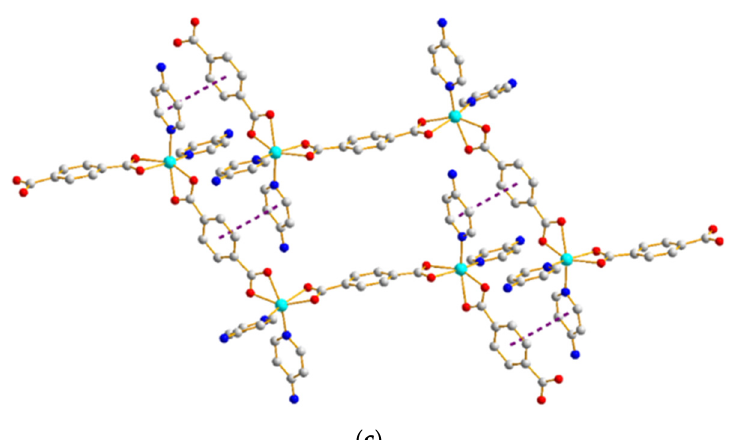
Figure 1. ( a ) A representative drawing showing the coordination environment of M(II) ion (M = Ni, 1a ; Co, 1b ). Symmetry transformations used to generate equivalent atoms: (A) − 0.5 + x, 1.5 − y, − 0.5 + z. ( b ) The M(II) ions are linked by 1,4-BDC 2 − ligands to form 1D zigzag chains. ( c ) The 1D chains are